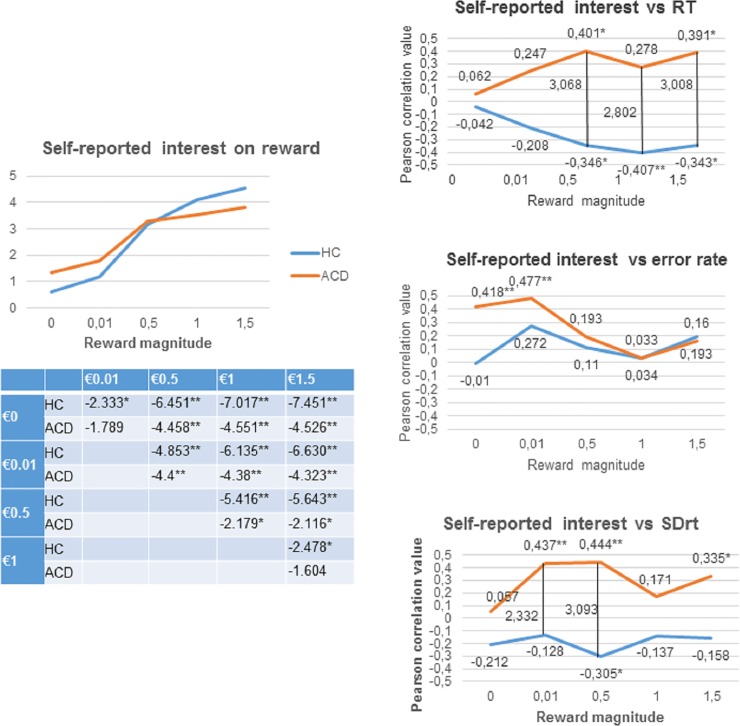
Graphical representation of associations between self-reported interest in reward value and performance, and between-group differences in these associations.The results in the left-hand table under the scatterplot shows the pairwise comparison t values (* = p < .05 and ** = p < .01) between conditions within groups. The results in the graphics on the right represent the Pearson correlation values between self-reported interest in the reward value and each behavioral variable of interest for each reward magnitude. The “*” represents significant (p < .05) and “**” represents significant (p < .01) in correlation coefficients. The numbers next to the vertical lines indicate the statistically significant between-group z-score after Bonferroni correction. RT, reaction time; SDrt, reaction time Standard Deviation; HC, Healthy Control; ACD, Abstinent Cocaine Dependent; €, euro.